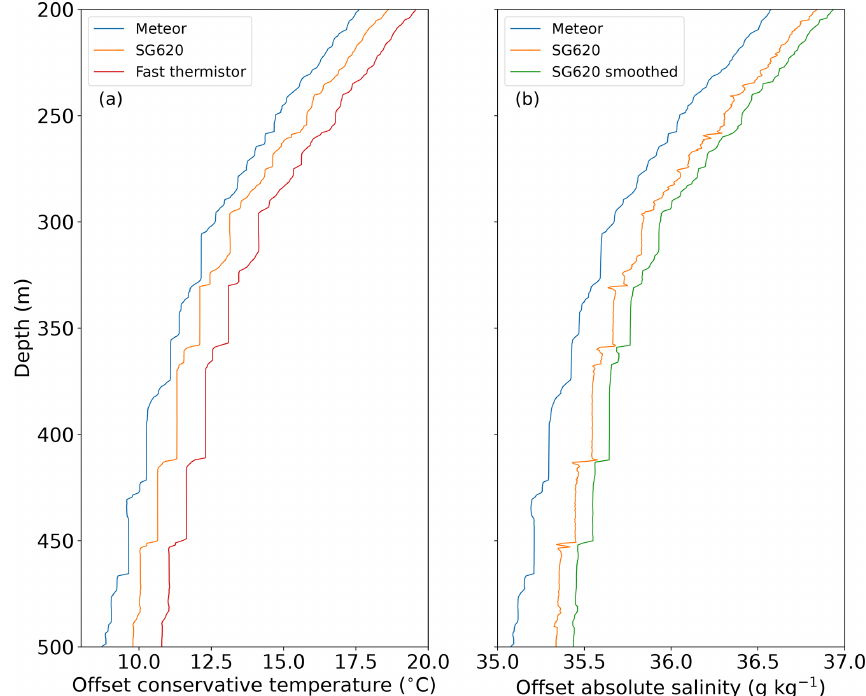
Figure 4. (a) Temperature profiles from Meteor CTD, SG620 CT sail and fast-response thermistor from the tropical North Atlantic. (b) Salin- ity from Meteor , salinity from SG620 and SG620 salinity smoothed with a 5m running mean. The profile from the Meteor was taken at the same location 24h before the glider dive. The first profile is unaltered; subsequent vertical profiles are offset by 1 ◦ C or 0.1gkg − 1 for